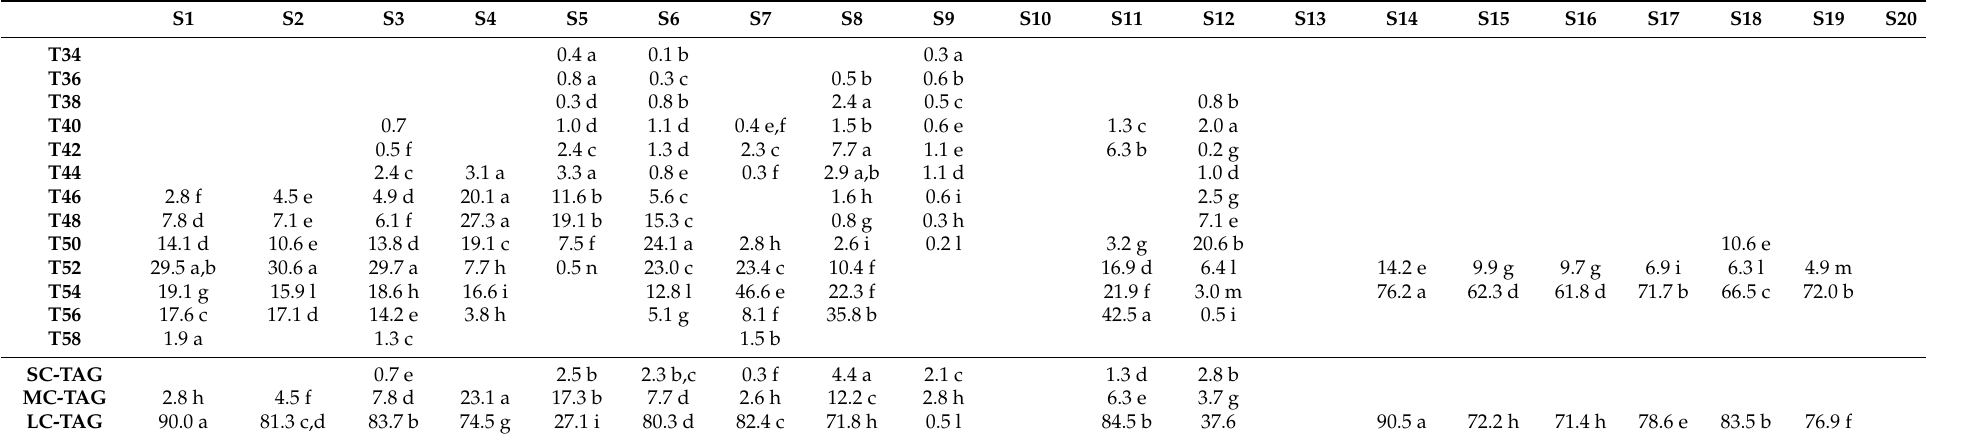
Table 3. Triglyceride composition (on total lipids) of supplement samples ( n =